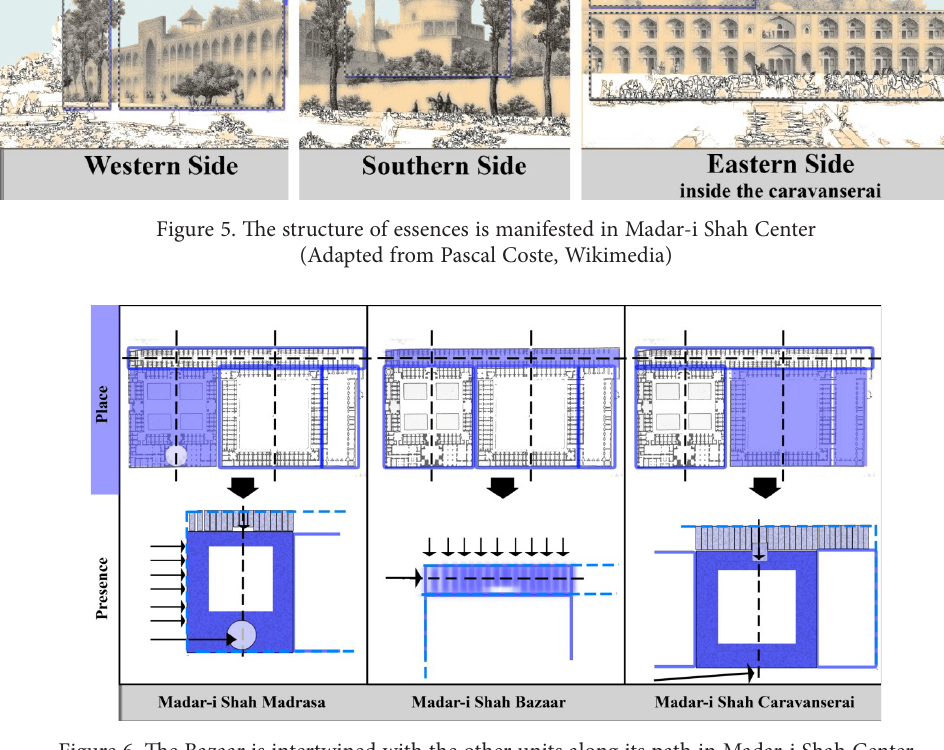
Figure 6. The Bazaar is intertwined with the other units along its path in Madar-i Shah